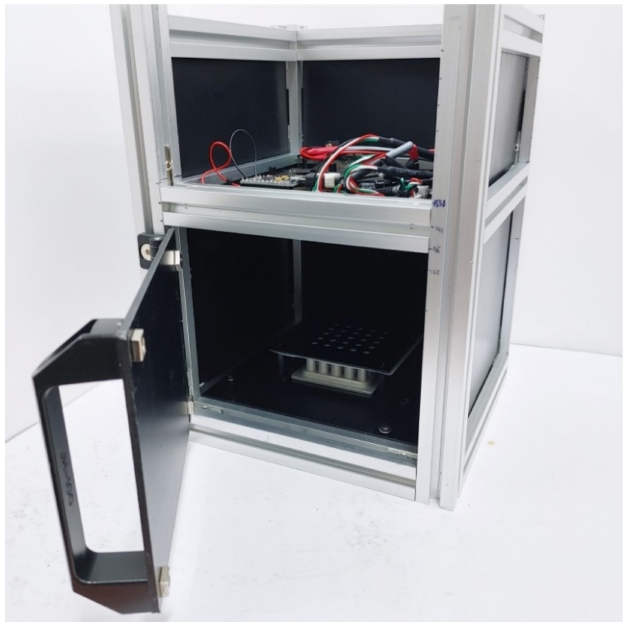
Figure 2. Proposed real-time PCR device.